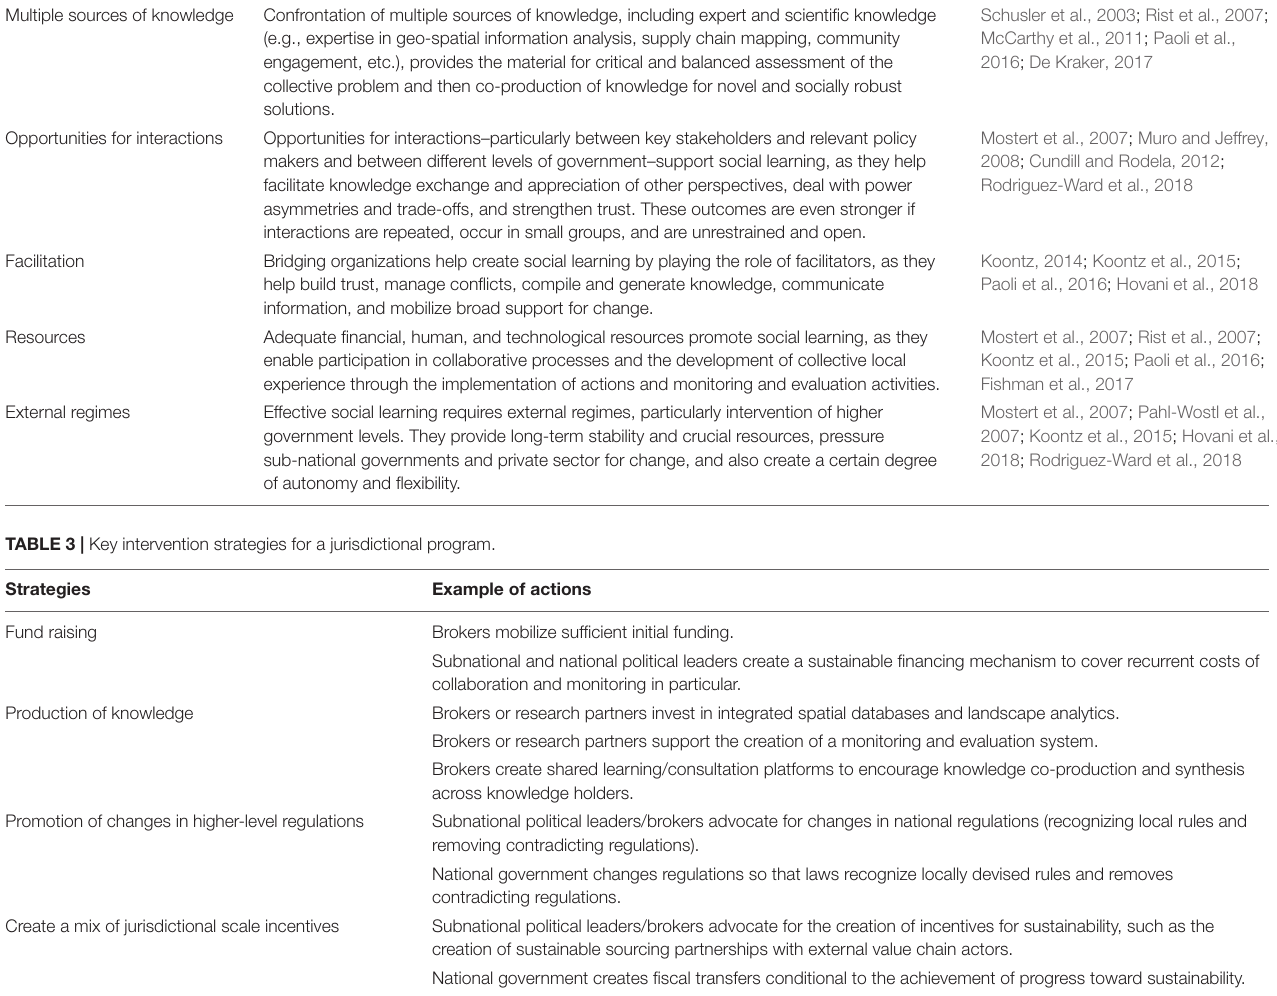
TABLE 2 | Key context-mechanism hypotheses for social learning in the case of Jas. Condition